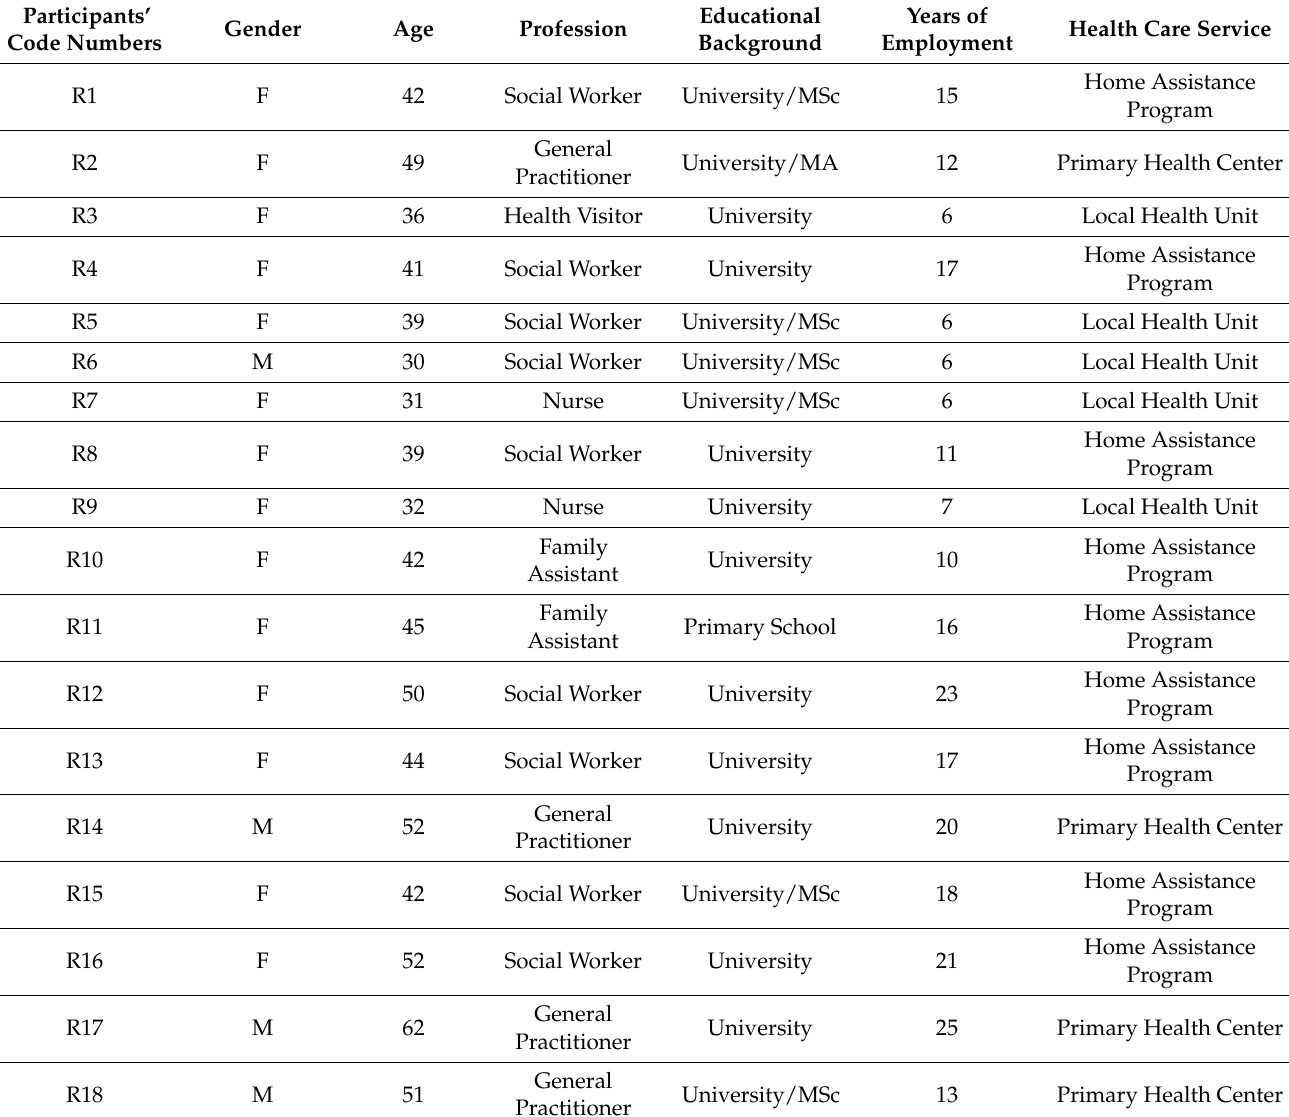
Table 1. Participants’ socio-demographic